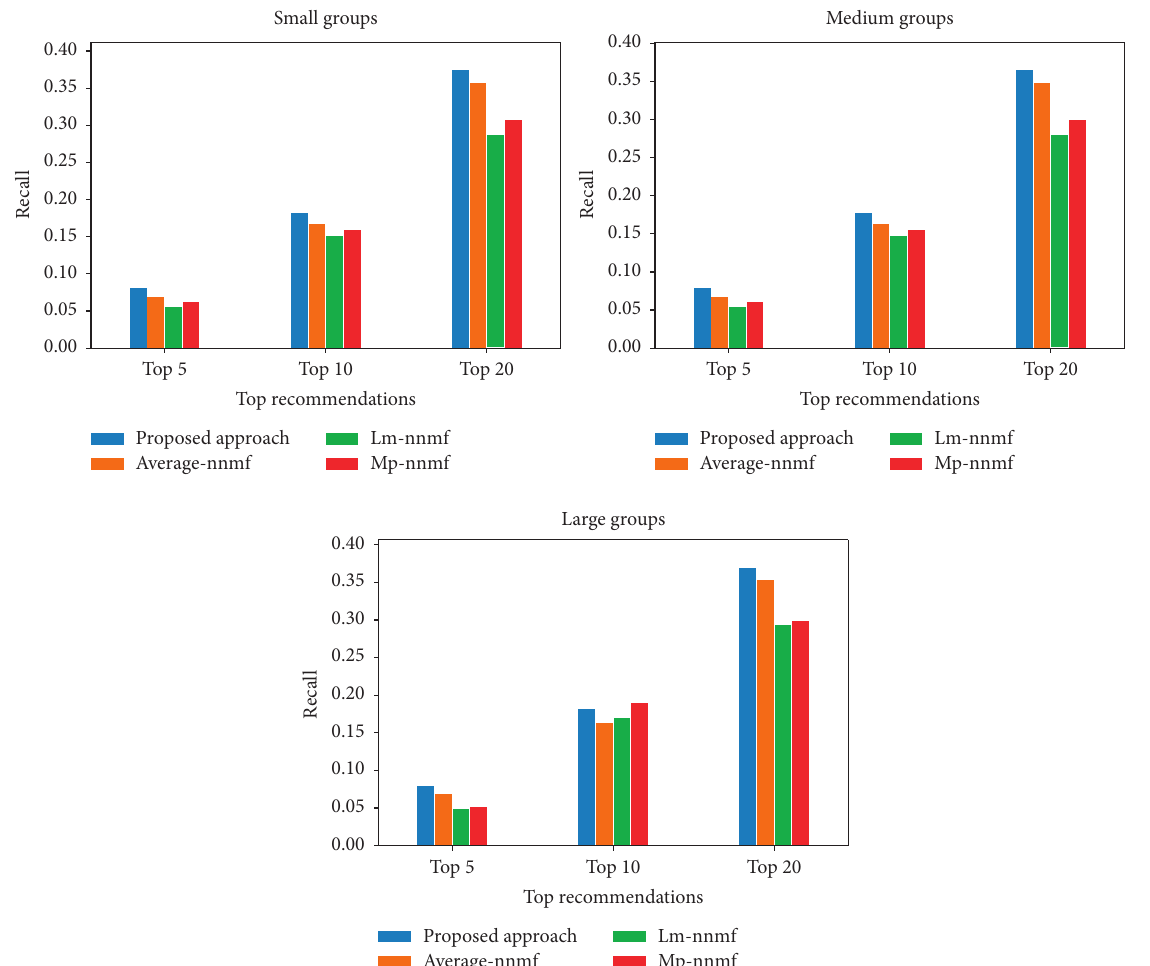
Figure 9: Recall of three types of group recommendations’